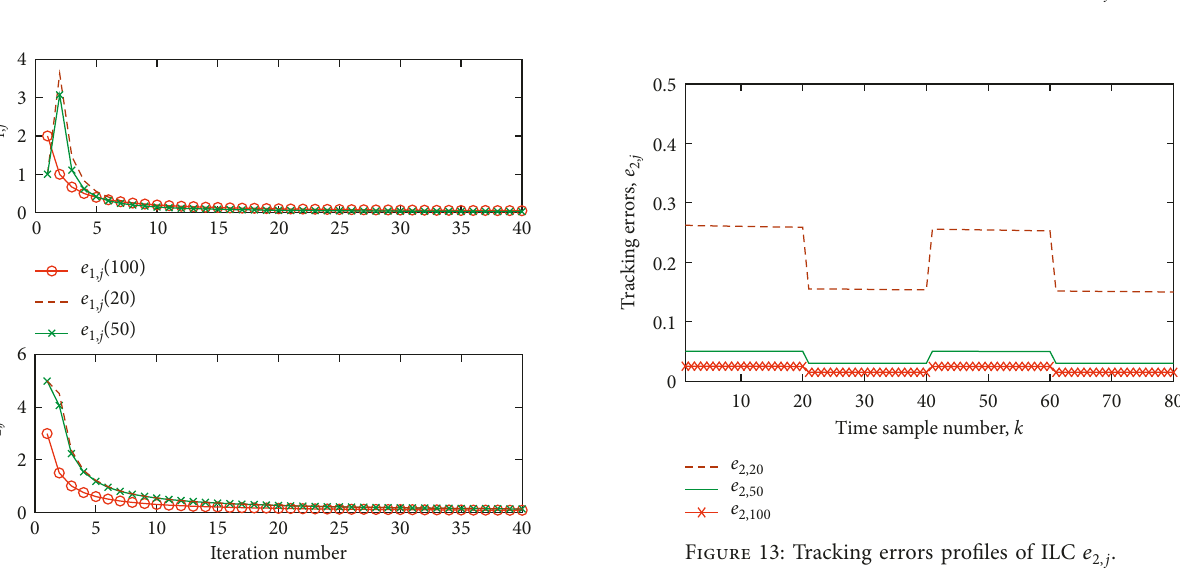
e 1 ,j and 2 ,j versus the iteration